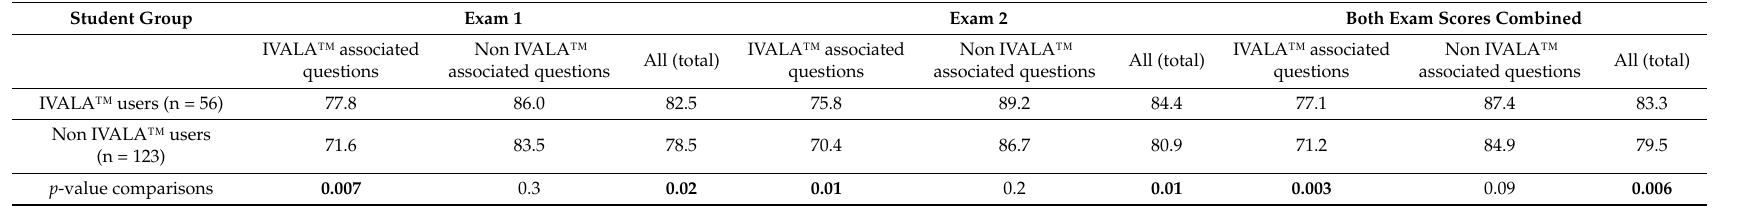
Table 1. Mean examination scores (%) from IVALA and Non IVALA users and all examination question